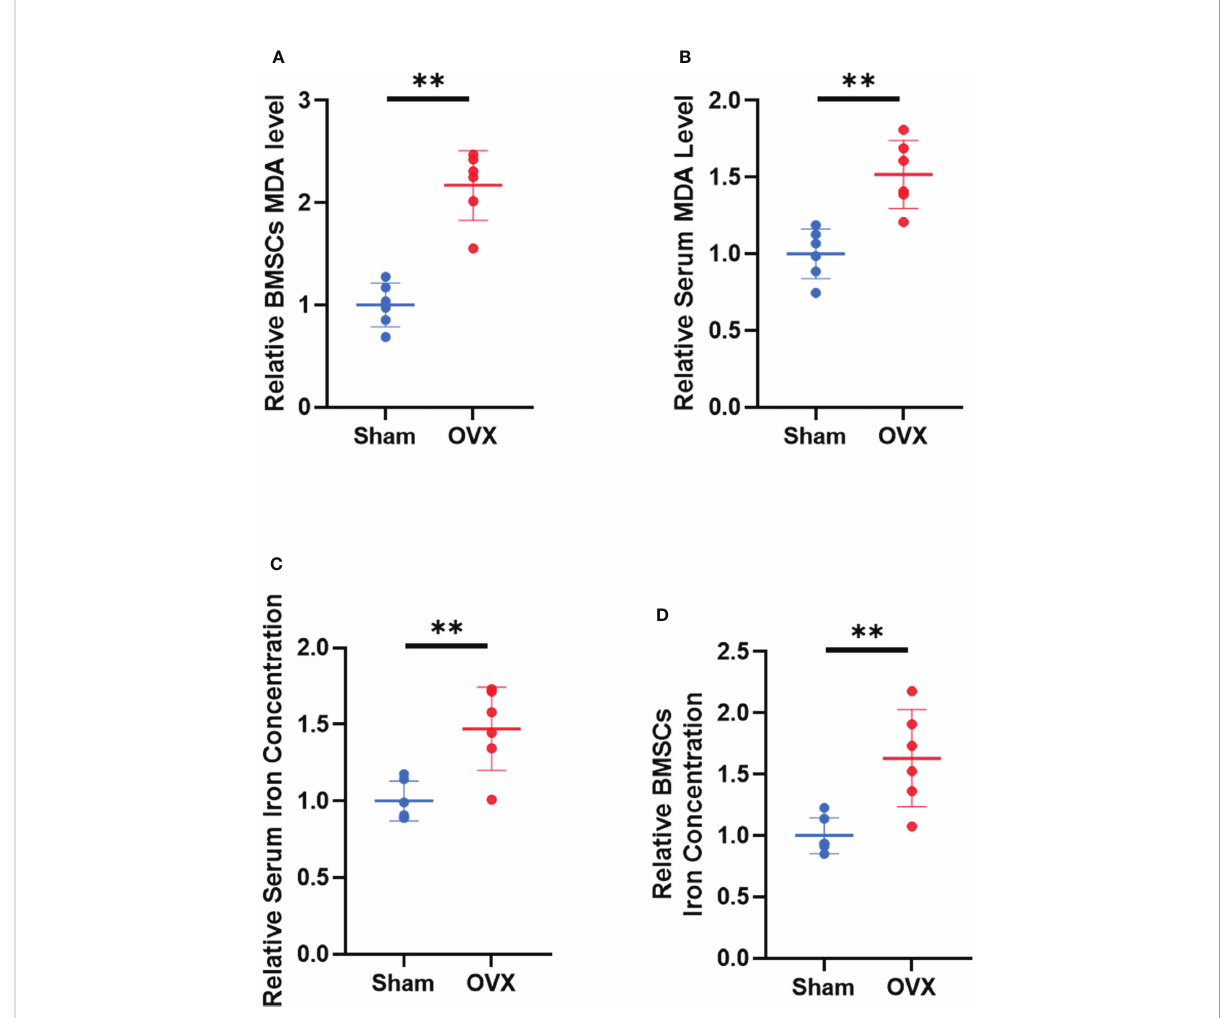
FIGURE 9 Validation of lipid peroxidation and iron level in vivo . (A, B) Relative expression of MDA in serum and BMSCs. (C, D) relative iron concentrations in serum and BMSCs. (The data are expressed as the mean ± sd **P <